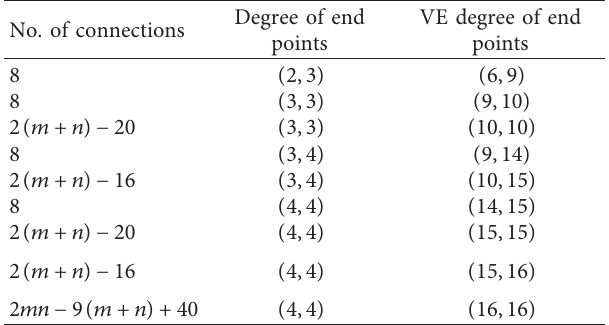
Table 5: The VE degree of the end points of connections of ) ( MN m × n